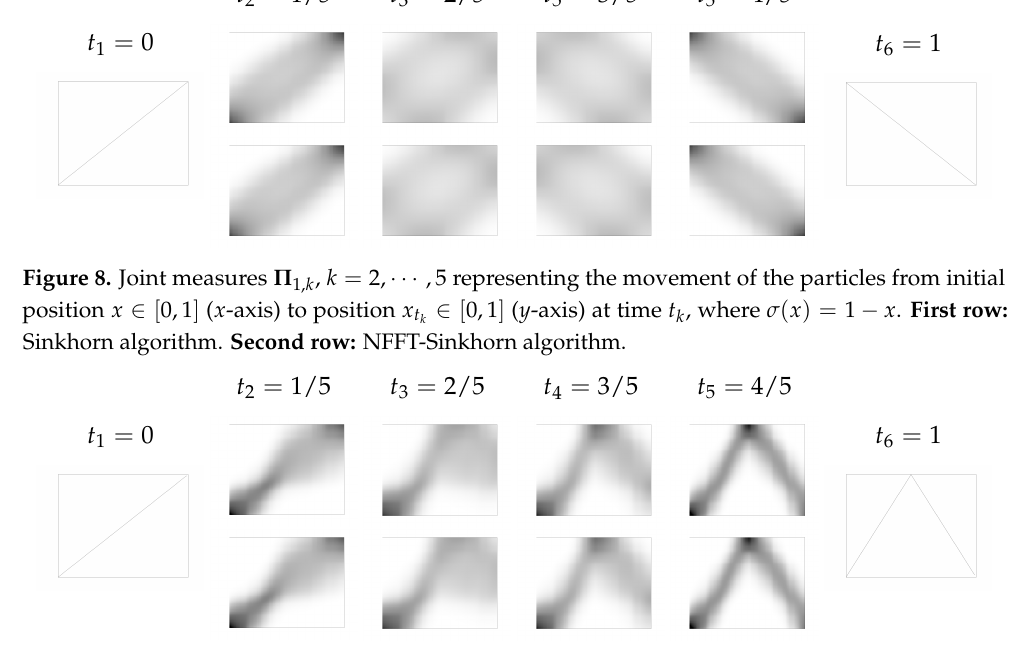
Figure 9. Joint measures as in Figure 8, but with the function σ ( x ) = min ( 2 x ,1 − 2 x )